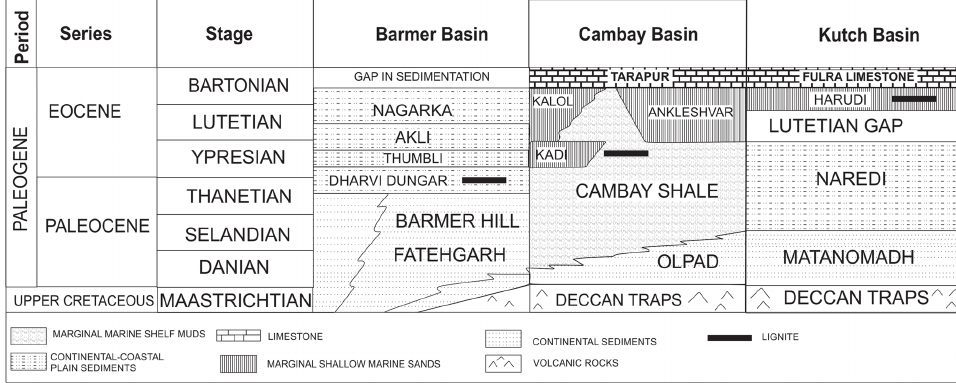
Figure 2. Eocene Stratigraphy of the Barmer, Cambay and Kutch basins in